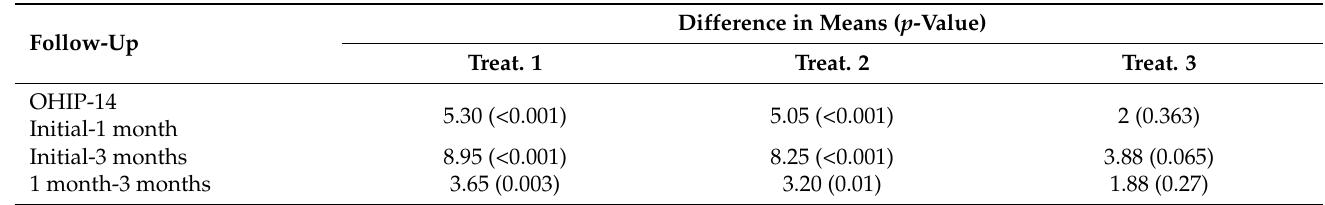
Table 5. Differences in means and p -values between the treatment groups at each of the